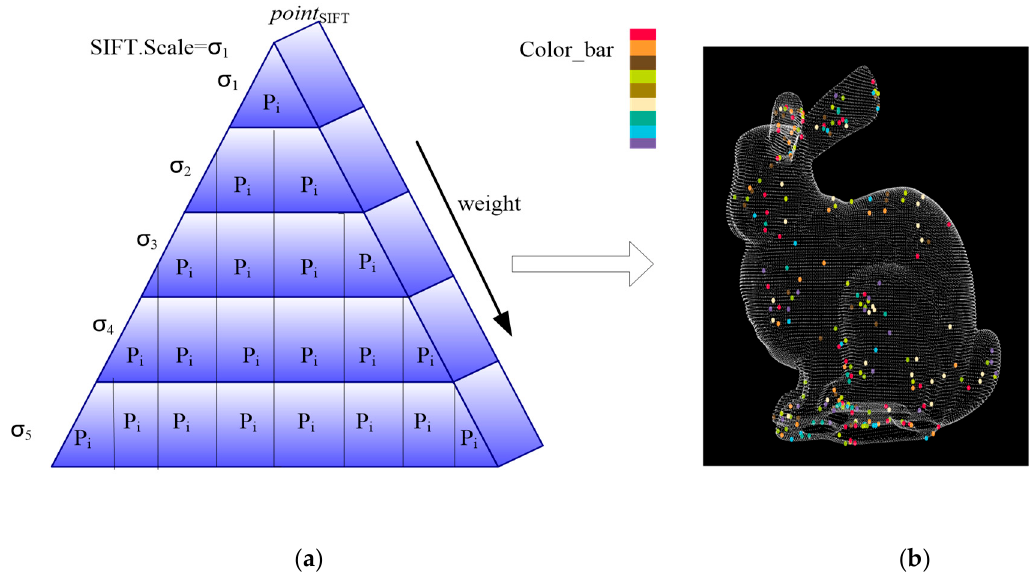
Figure 4. The pyramid of scale-keeping simplification entropy: ( a ) the multi-layer pyramid; ( b ) the view of point SIFT elements in different layers.